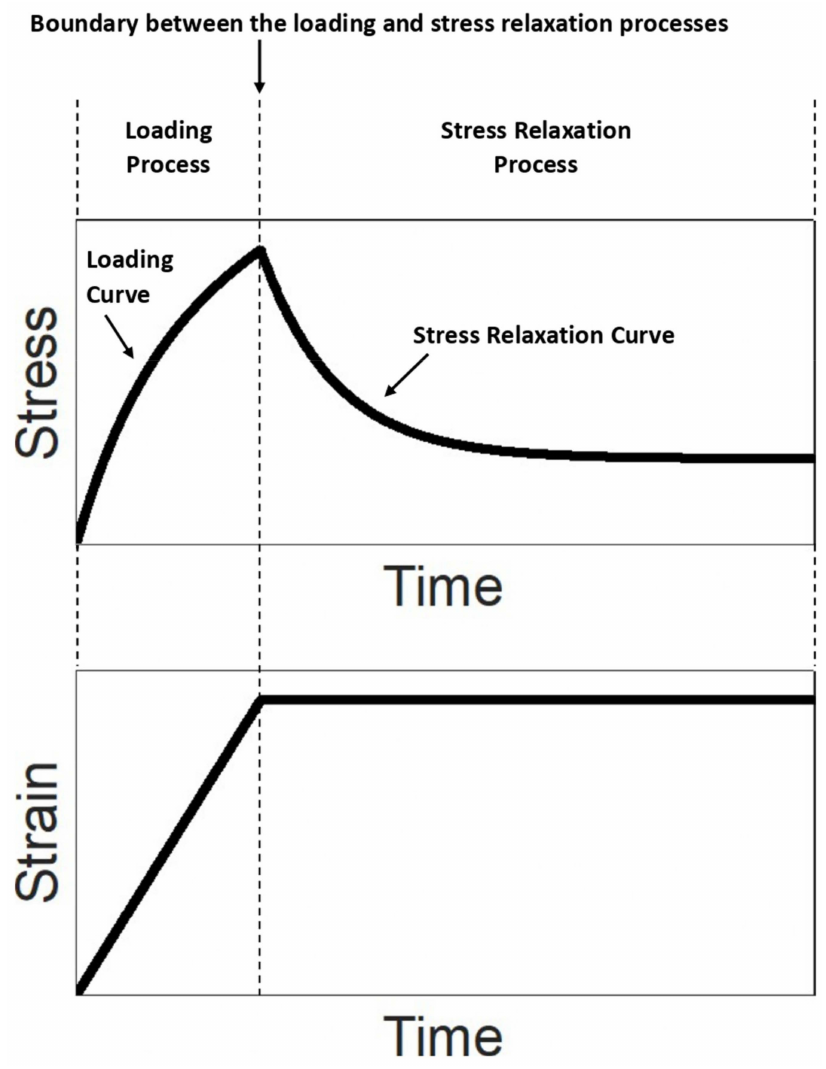
Figure 2. Illustration of the stress–time and strain–time relationships in the stress relaxation